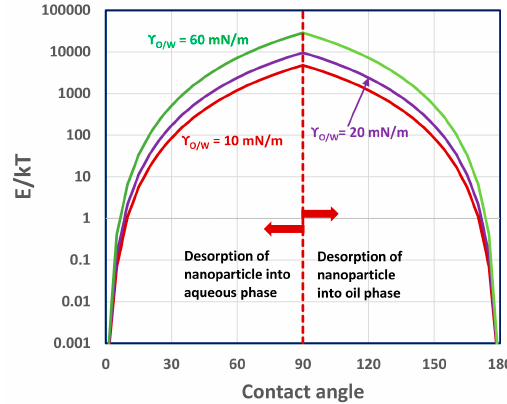
Figure 4. Relative desorption energy of a single solid nanoparticle as a function of contact angle θ for different values of interfacial tension.